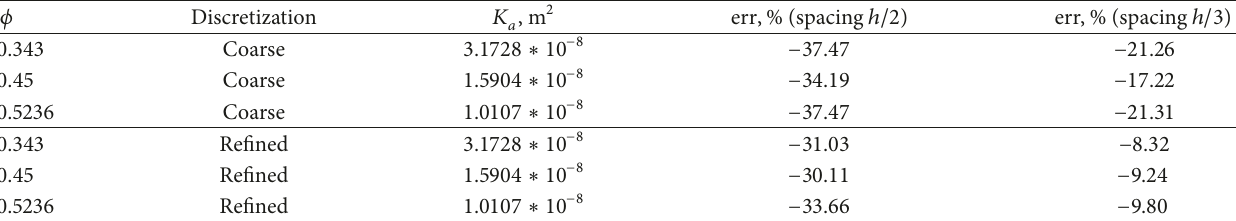
of periodic array of num